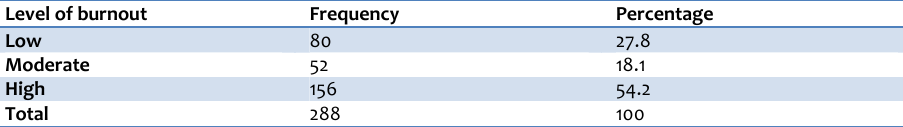
Table 3: Frequency and Percentage of Emotional Exhaustion among Sample Teachers Level of burnout